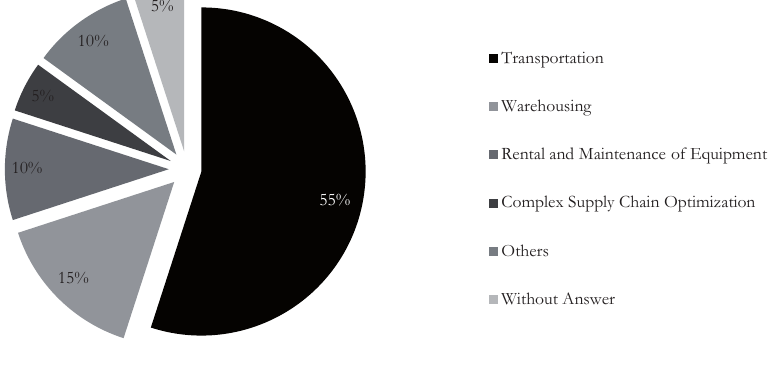
Fig. 1 – Areas of Logistics Outsourcing. Source: Authors´